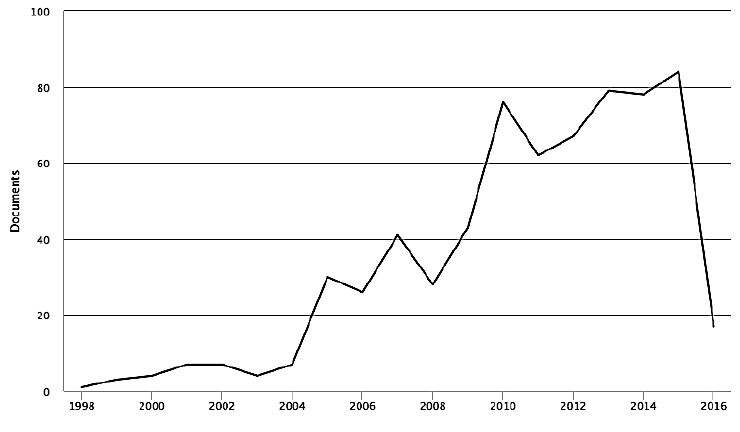
Figure 1. First selection of documents by year.